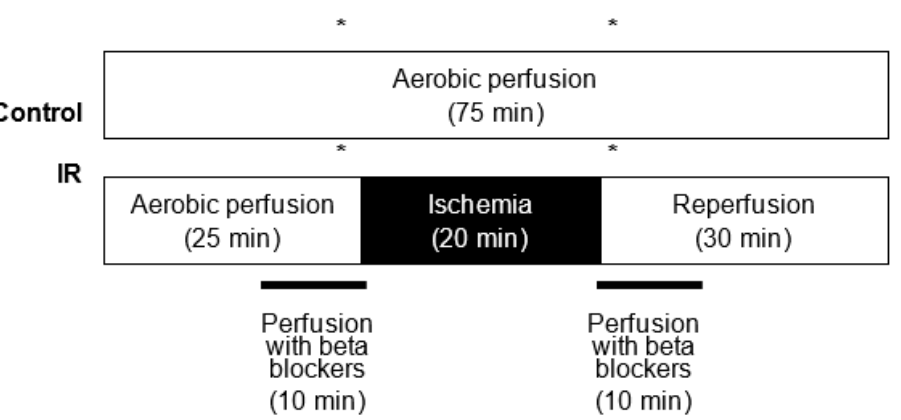
Figure 7. Experimental protocol for isolated heart perfusions. Detailed description in Material and methods part, “heart perfusion protocol” section. * show times when coronary effluent samples were collected during aerobic perfusion (23–25 min) and in the first 2 min of reperfusion (45–47 min).